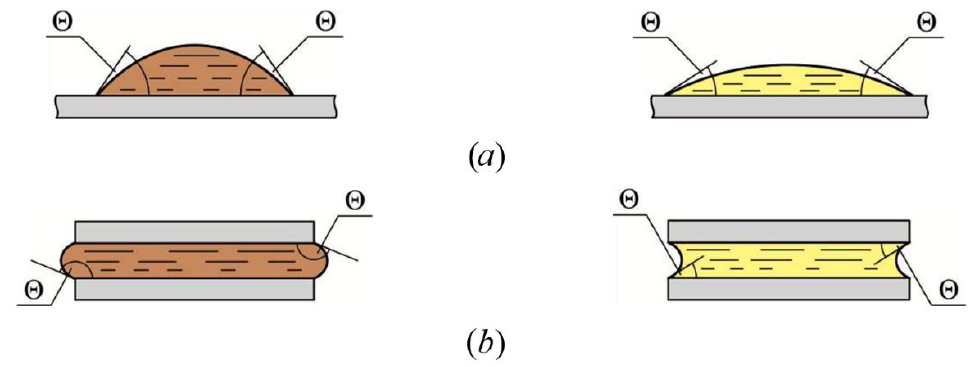
Figure 2. Oil wetting angles: ( a ) on a surface; ( b ) in tribological conjugation. Determination of wetting angles θ , as well as the thickness of the oil layer d oil , possibly ellipsometrically by analysing the light rays reflected from the oil and from the surface (Figure 3) [52].